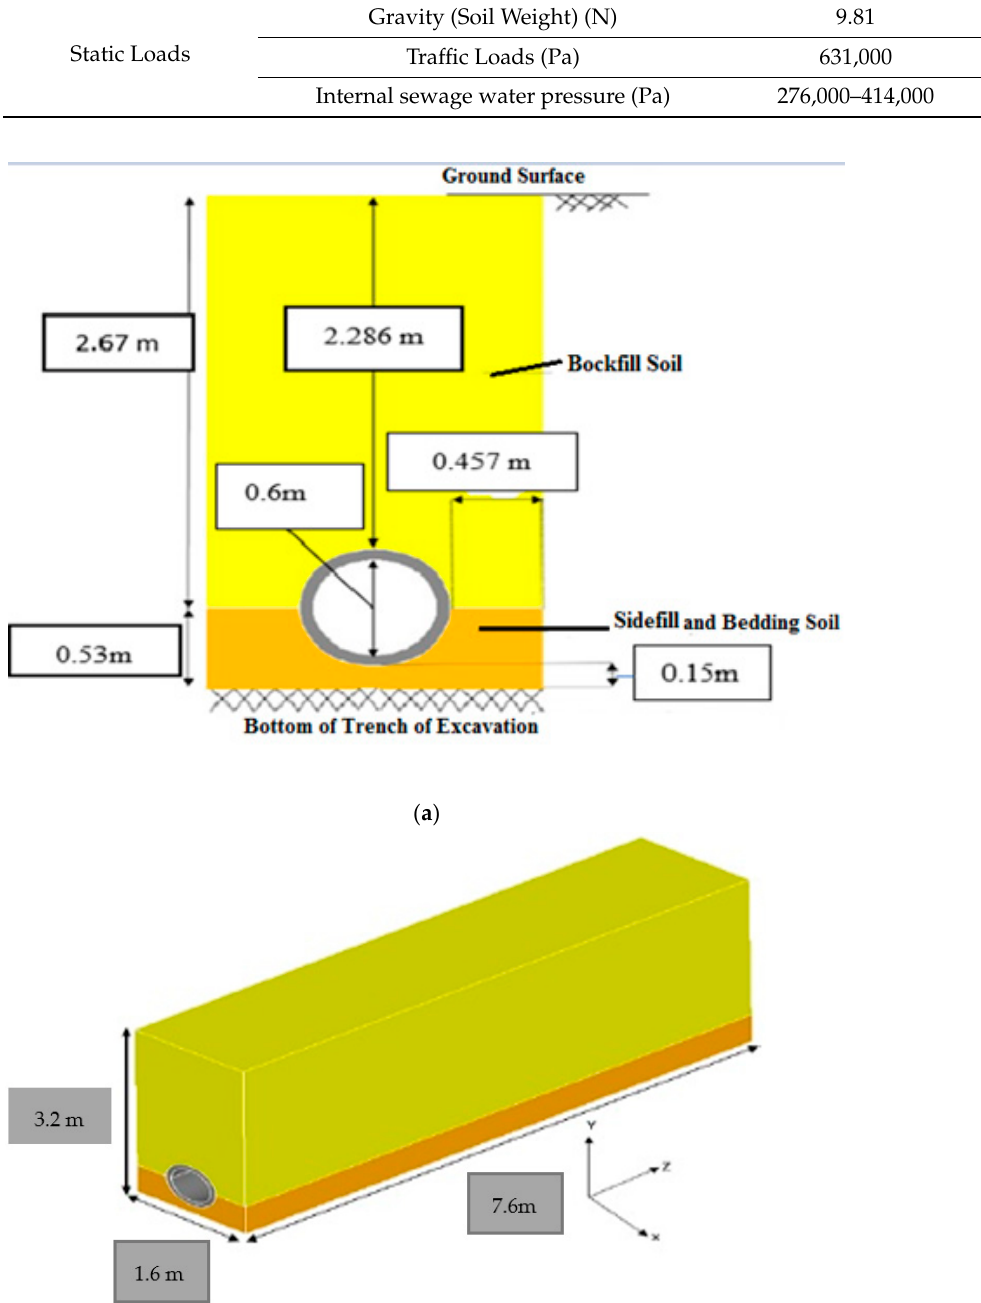
Table 3. Comparison of numerical results in the present study and the modified Popovics model.